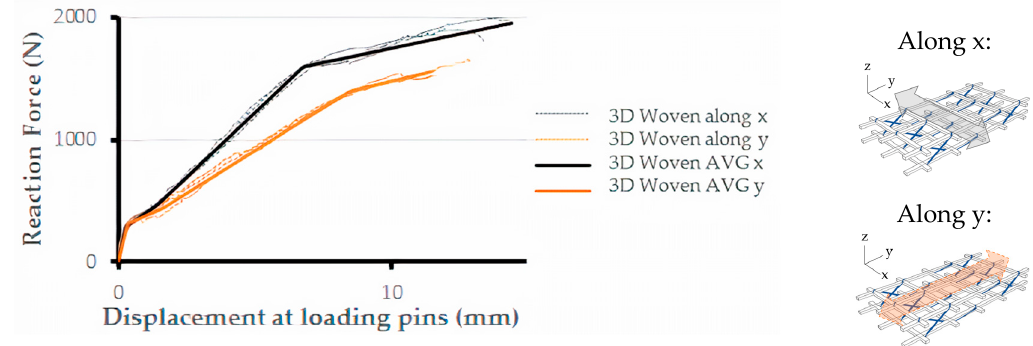
Table 8. Averaged stiffness in three stages in bending for all layups.